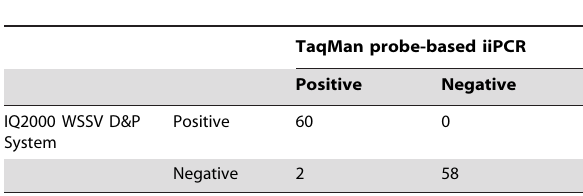
Table 2. Agreement of WSSV DNA detection between IQ2000 WSSV D&P System and WSSV TaqMan probe-based iiPCR.